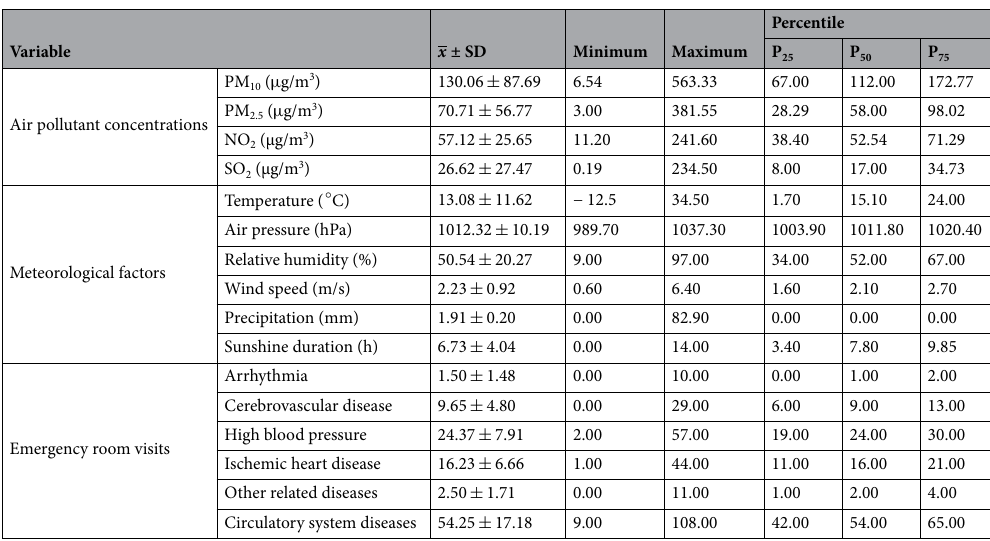
Table 1. Descriptive statistics of air pollutants, meteorological factors, and emergency room visits in Beijing, China from 2009 to 2012. SD standard